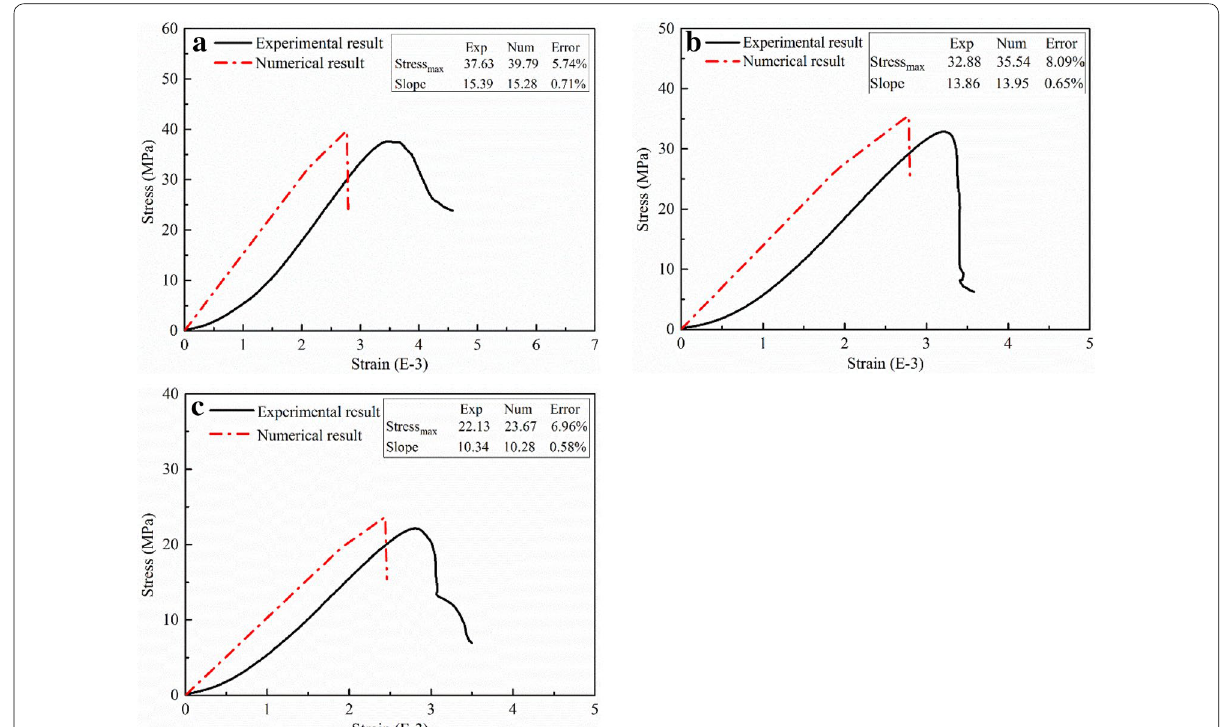
Fig. 10 Comparison of stress–strain plot from numerical models and experiments of specimens mixed with a P1 (100% 5–10 mm aggregate), b P3 (50% 5–10 mm aggregate) and c P5 (100% 10–15 mm